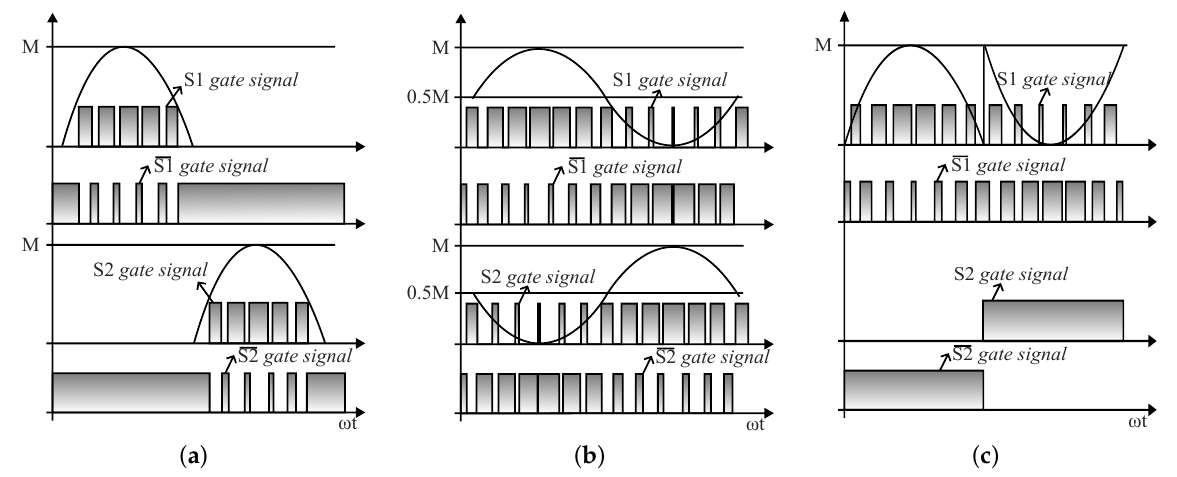
Figure 1. Three-level modulations applied to single-phase full-bridge inverter. ( a ) DM. ( b ) PS. ( c )